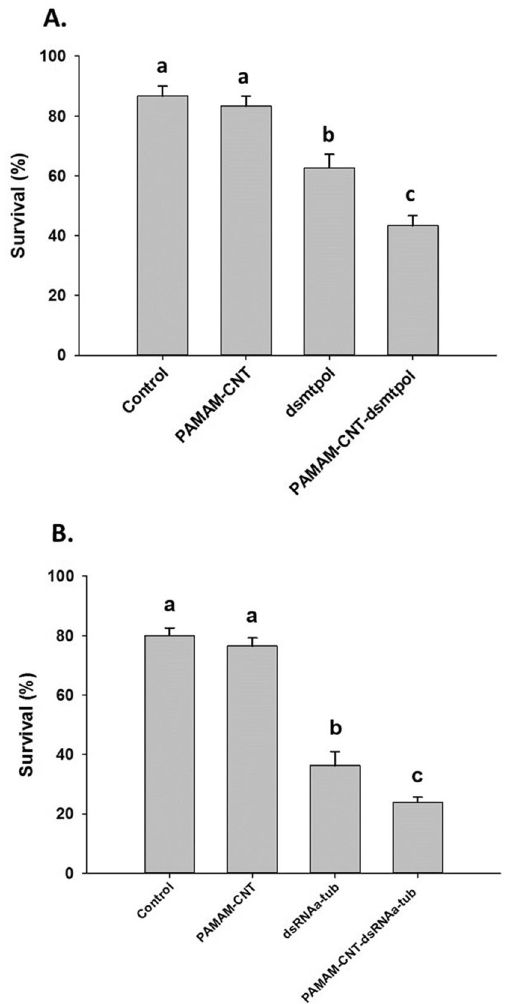
Figure 5. Survival of larvae injected with saline (control), naked PAMAM-CNTs, dsRNA or PAMAM-CNT- dsRNA at 96 h post-injection. Larvae were assessed every 24 h for mortality. PAMAM-CNT-dsRNA mtpol injected larvae ( A ) had significantly increased mortality compared with dsRNA mtpol alone ( P < 0.05). PAMAM-CNT- dsRNA αtub injected larvae ( B ) had significantly increased mortality compared with dsRNA αtub alone ( P = 0.041). The data are presented as means ± SEM (4 replicate groups, n = 10–11 per group). Different letters indicate significant difference in survival between treatments (a > b >